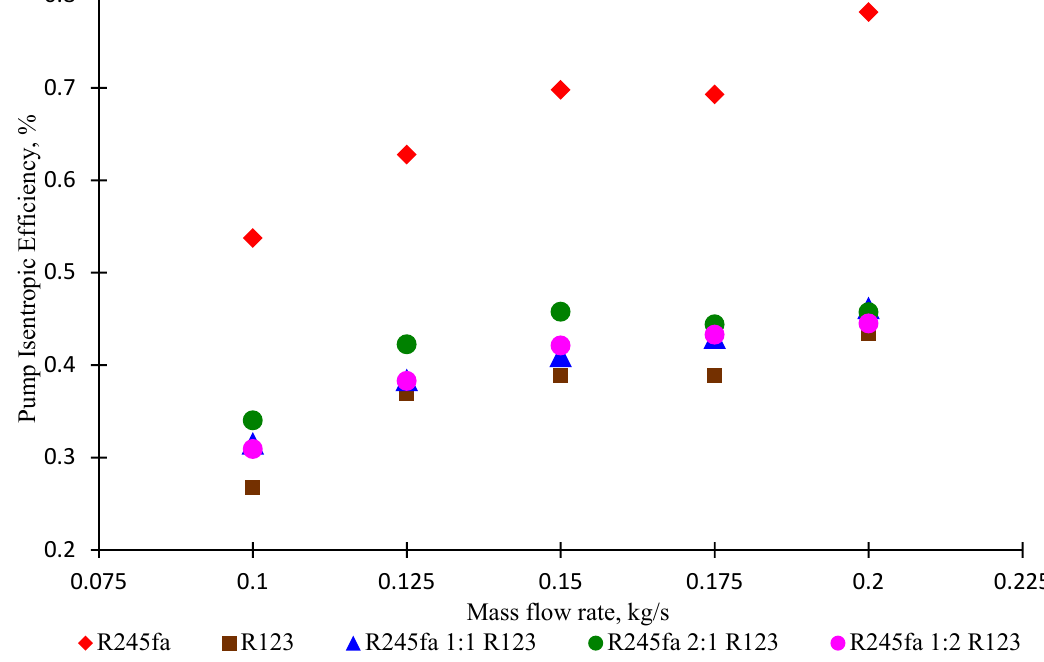
Figure 16. Pump isentropic efficiency as a function mass flow rate for R245fa, R123, and mixed working fluids with heat source at 120 ° C.